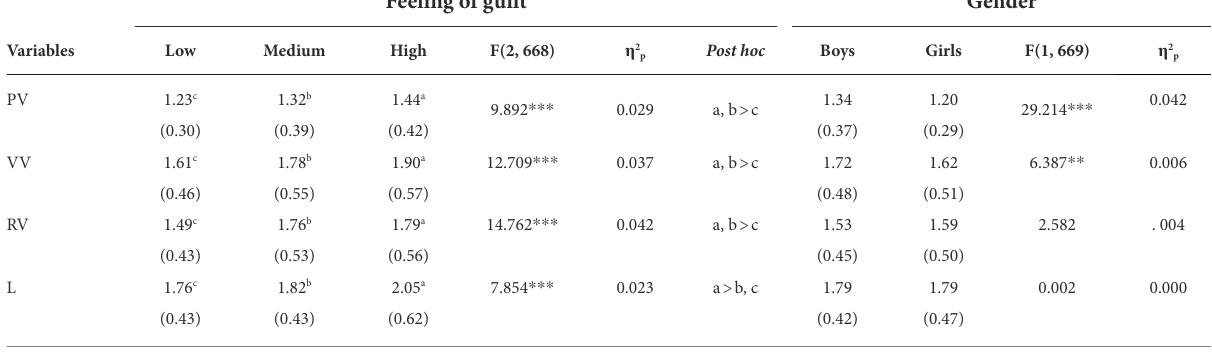
TABLE 2 Means, standard deviations, and differences on guilt, peer victimization, and